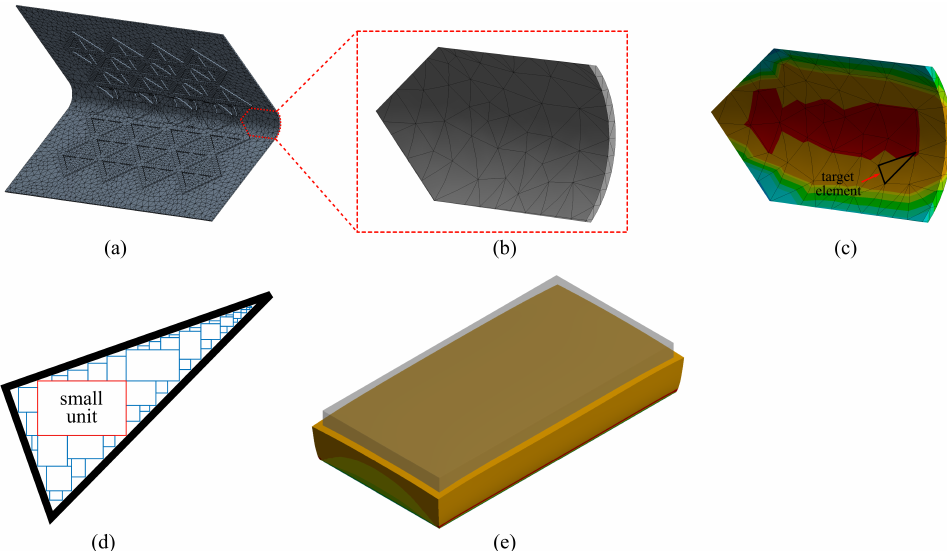
Figure 6. Schematic drawings show: ( a ) meshed cSEC; ( b ) details of partitioned elements; ( c ) normal elastic strain distributed on target element; ( d ) selected mesh element; ( e ) small cuboid unit of the mesh element under